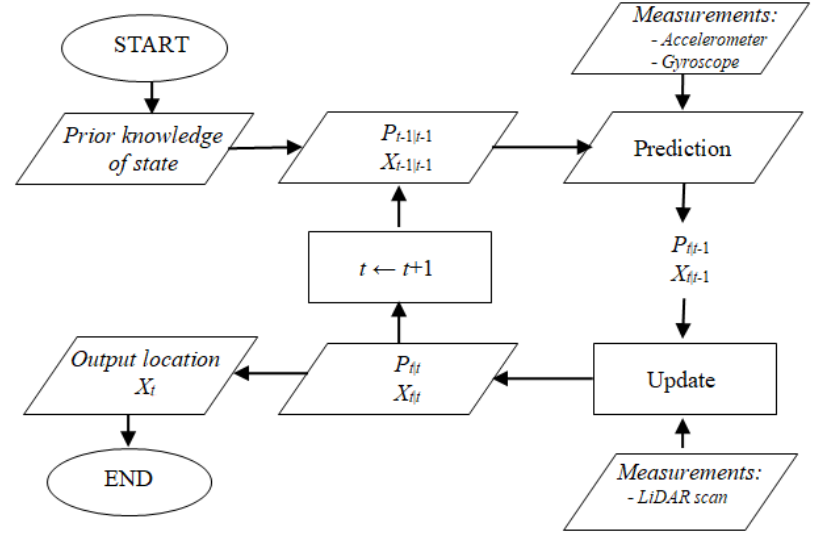
Figure 1. Outline of the single loop of the localization algorithm that is executed for each LiDAR scan